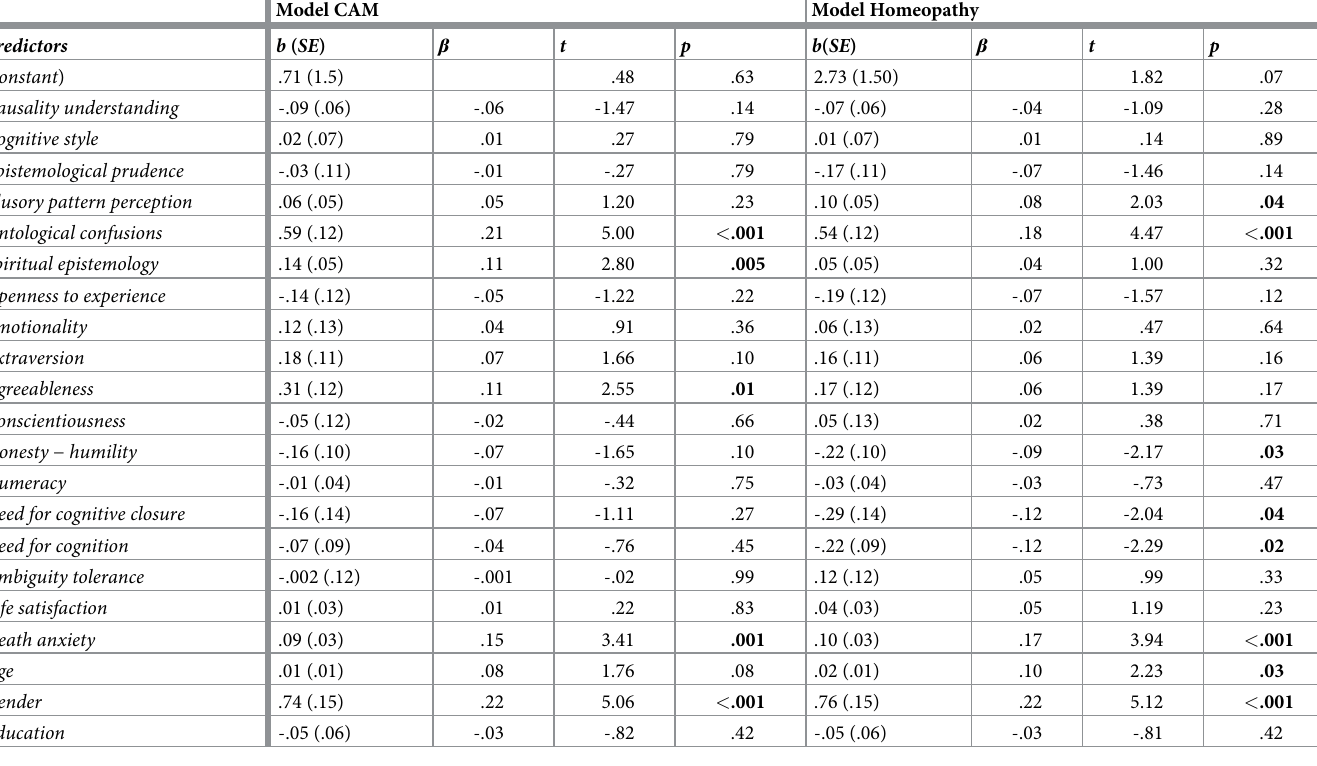
Table 2. Results of regression analysis with cognitive, personality, and socio-demographic variables as predictors as well as CAM belief and belief in homeopathy as